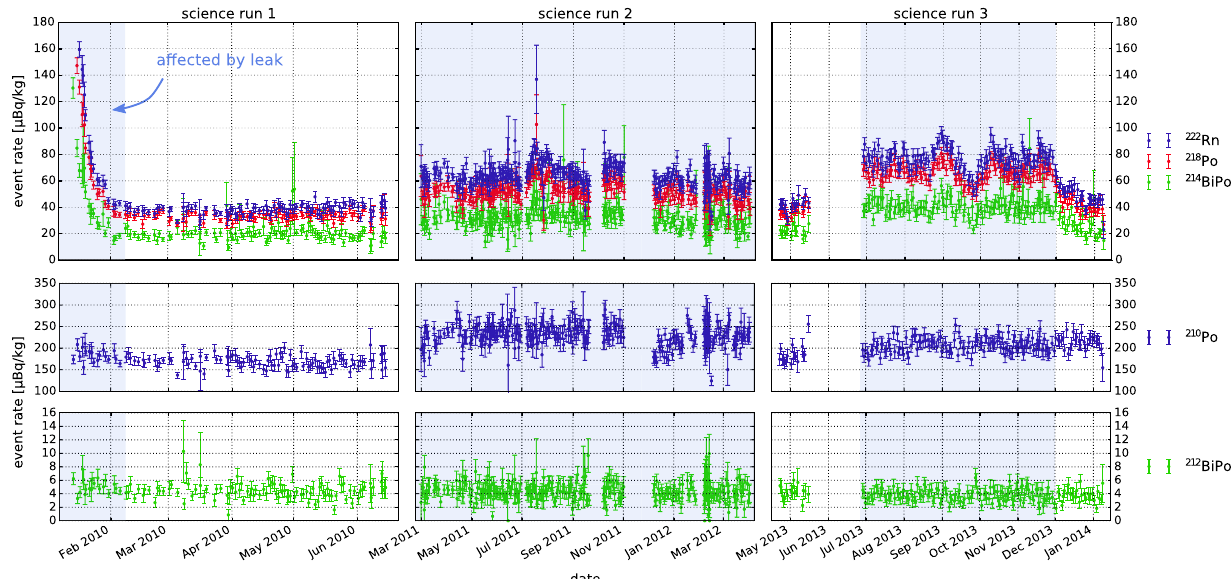
Fig. 3 Radon event rates during the three SRs. Before starting SR1, 222 Rn entered the detector via an air leak which was subsequently closed. The decay of this additional radon contribution is clearly visible intherates,andthedecayconstantiscompatiblewithexpectationsfrom literature values (see text for more details). Note the rate correlation among 222 Rn, 218 Po(selectedby α -counting)and 214 BiPos(selectedby